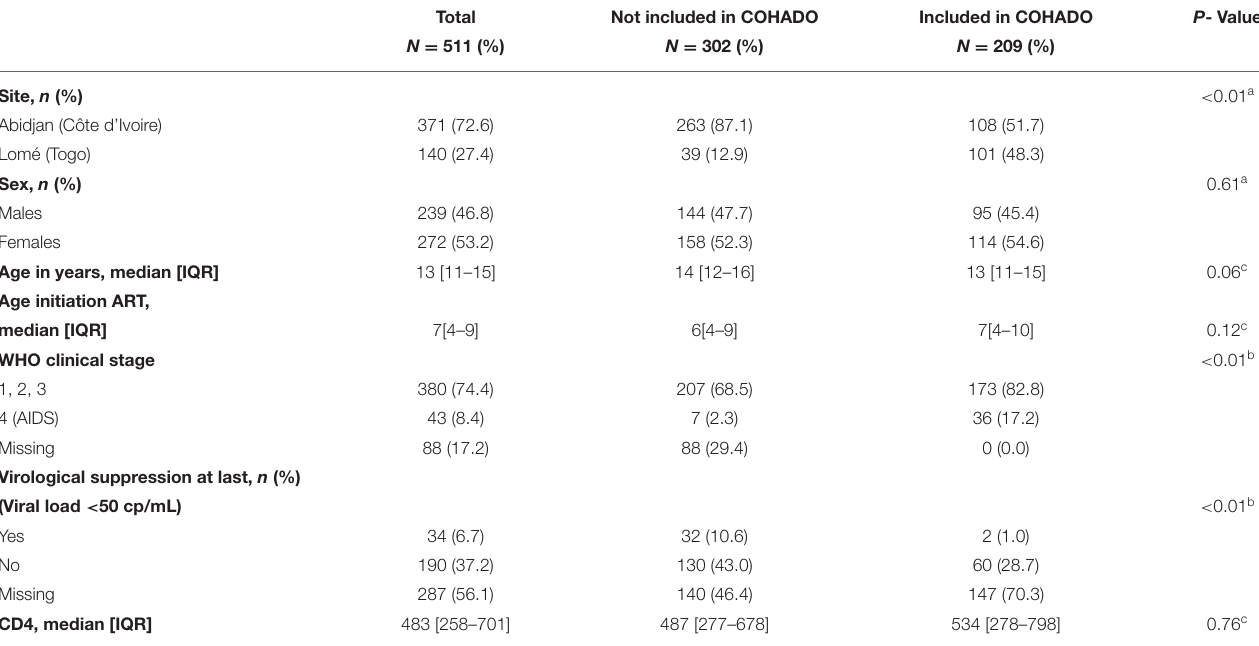
TABLE 1 | Characteristic of eligible adolescents living with perinatally-acquired HIV (APHIV) included in the COHADO cohort compared to those who were not included, during the inclusion period in Abidjan (Côte d’Ivoire), Lomé (Togo), IeDEA-pWADA,